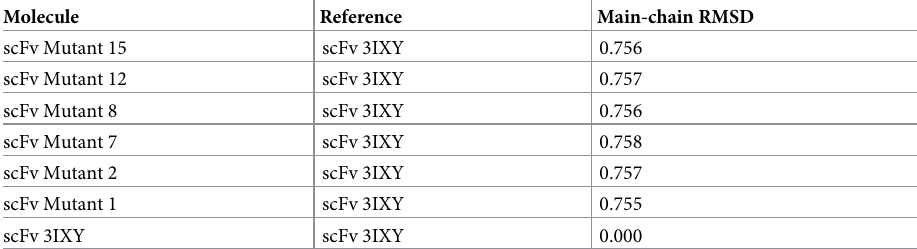
Table 4. scFv molecular overlay with mutant superimposition RMSD.